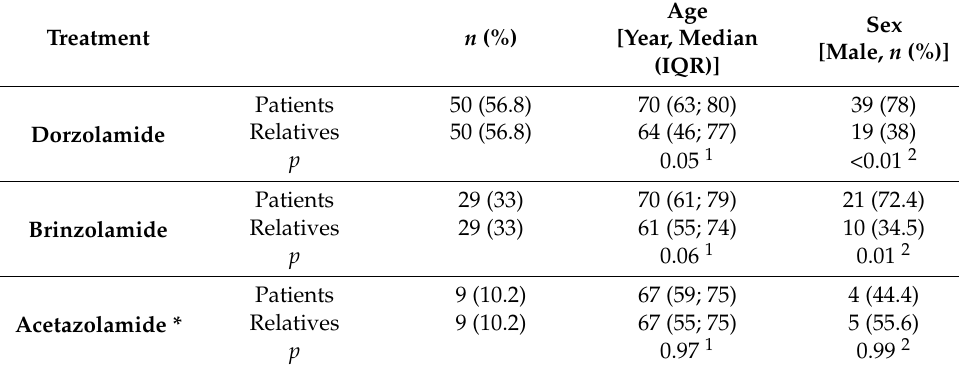
(Table 1). Gender-related discrepancies in dorzolamide, brinzolamide, and acetazolamide pharmacokinetic profiles are unknown. Table 1. Patient and relative characteristics according to patients’